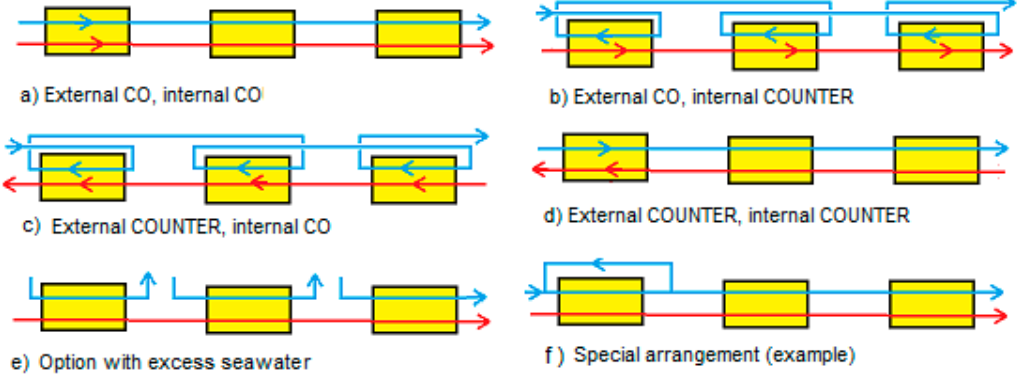
Figure 8. Different multistage systems. Systems externally operated in ( a , b ) co-flow mode; ( c , d ) counterflow mode. Internal co-flow is seen in ( a , c ), whereas internal counterflow occurs in ( b , d ). Systems ( a – d ) are the subject of this article. System ( e ) is an option if there is a large excess of seawater (blue flow paths) available. System ( f ) is an example of numerous other interconnections and is taken from Tedesco et al. [13].